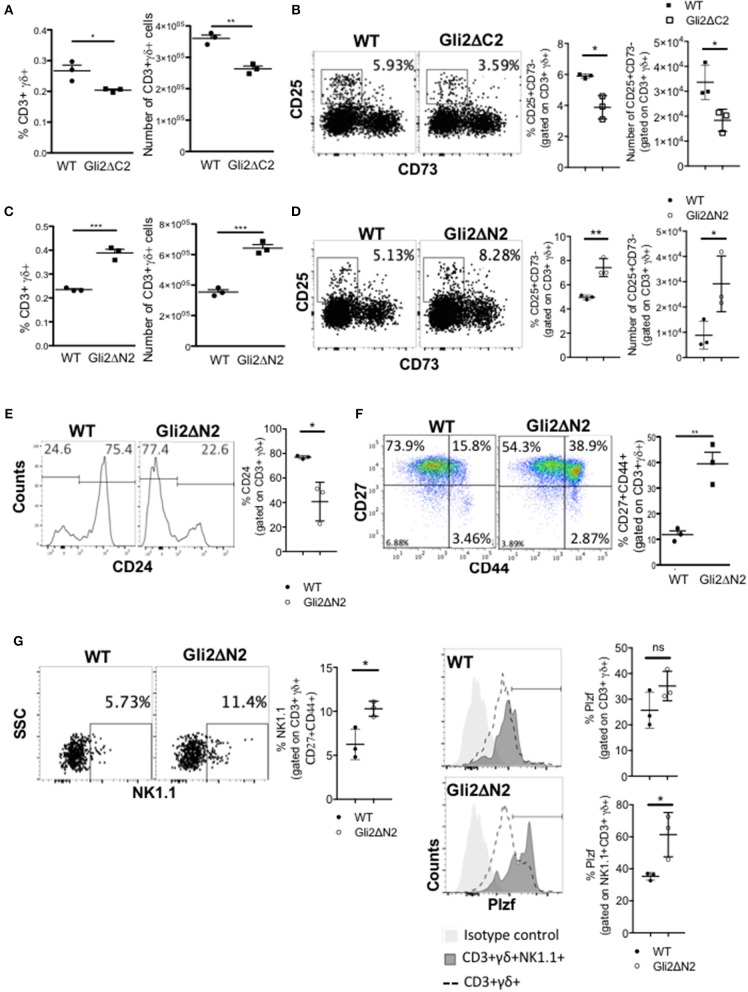
Hh-mediated transcription promotes γδ T-cell development and influences γδ subset distribution in adult thymus. (A) The proportion and number of CD3+γδ+ cells recovered from WT (n = 3) and Gli2ΔC2-tg (n = 3) littermate adult thymus. (B) Representative dot plots show CD25 and CD73 expression, gated on CD3+γδ+ cells from WT and Gli2ΔC2-tg, giving the percentage of cells in the CD25+CD73- region shown. Scatter plots show the percentage of CD25+CD73- cells, gated on CD3+γδ+ (left) and number of CD25+CD73-CD3+γδ+ cells recovered (right) from WT (n = 3) and Gli2ΔC2-tg (n = 3). (C–G) Flow cytometry analysis of WT (n = 3) and Gli2ΔN2-tg (n = 3) littermate adult thymus. (C) The proportion and number of CD3+γδ+ cells recovered. (D) Representative dot plots show CD25 and CD73 expression, gated on CD3+γδ+ cells from WT and Gli2ΔN2-tg, giving the percentage of cells in the CD25+CD73- region shown. Scatter plots show the percentage of CD25+CD73- cells, gated on CD3+γδ+ (left) and number of CD25+CD73-CD3+γδ+ cells recovered (right). (E) Representative histograms show anti-CD24 staining, gated on CD3+γδ+. Scatter plots show the percentage of CD24+ cells, gated on CD3+γδ+. (F) Representative dot plot shows anti-CD27 and anti-CD44 staining, gated on CD3+γδ+, giving the percentage of cells in each quadrant. Scatter plot shows the percentage of CD27+CD44+ cells, gated on CD3+γδ+. (G) Representative dot plot shows anti-NK1.1 staining against SSC, gated on CD3+γδ+CD44+CD27+, giving the percentage of NK1.1+ cells in the region shown. Middle scatter plot shows the percentage of NK1.1+ cells, gated on CD3+γδ+CD44+CD27+. Representative histogram overlays show intracellular anti-PLZF staining, gated on CD3+γδ+ (dotted lines) and on CD3+γδ+NK1.1+ (dark shading) and isotype control staining (light shade) on WT (upper) and Gli2ΔN2-tg (lower) thymus. Scatter plots how the percentage of PLZF+ cells (cells within the marker in the histogram), gated on CD3+γδ+ (upper plot) and on CD3+γδ+NK1.1+ (lower plot). In all scatter plots in this figure, each point represents an individual mouse and bars show mean ± SEM. *p < 0.05; **p < 0.01; ***p < 0.005.